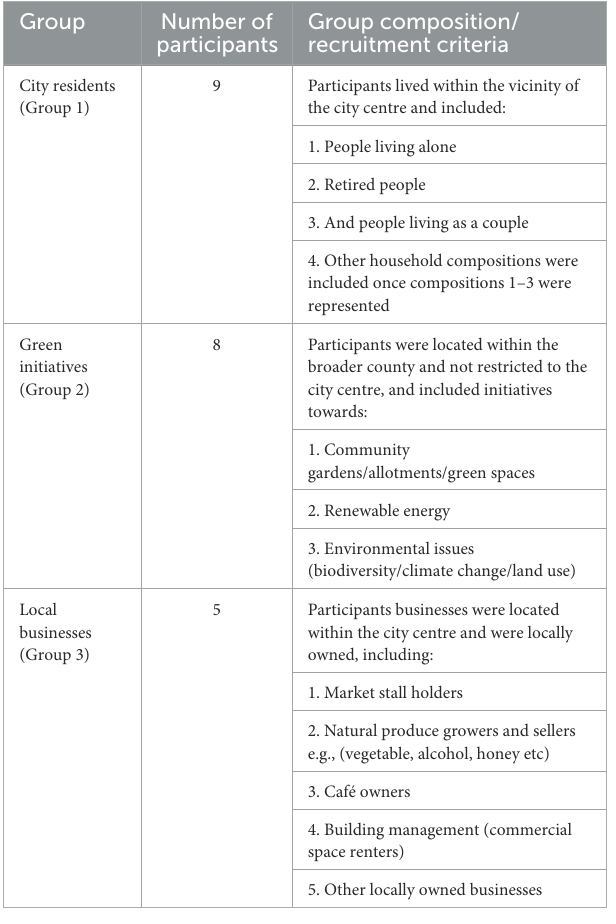
TABLE 1 Focus group